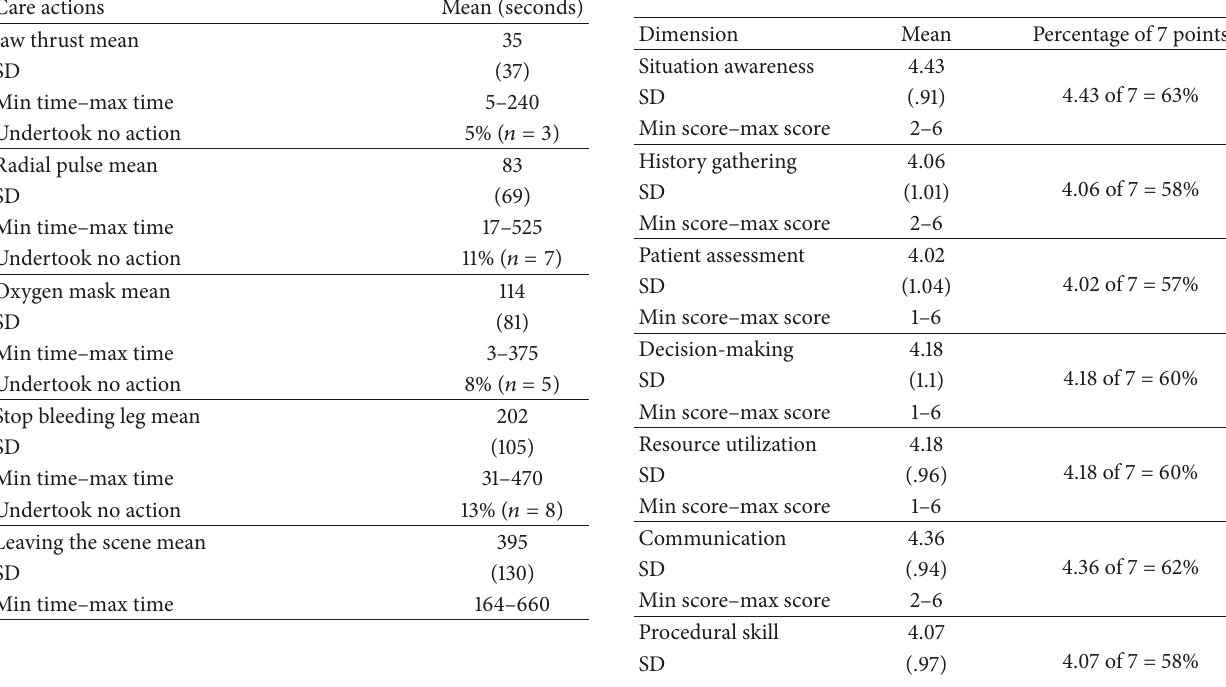
Table 3: The response time to critical care actions. Table 4: Score per dimension, total score on the 7-point Likert scale, and percentage of 7